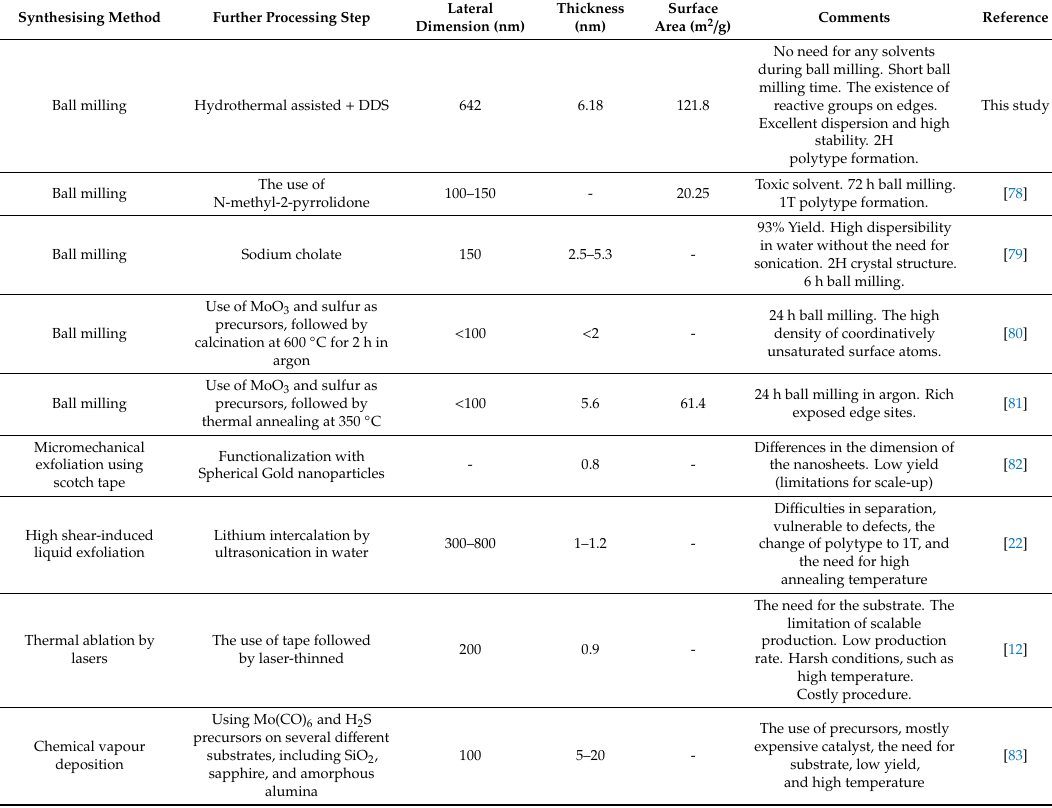
Table 2. Comparison of properties of the produced F-MoS 2 nanosheets with recent works.